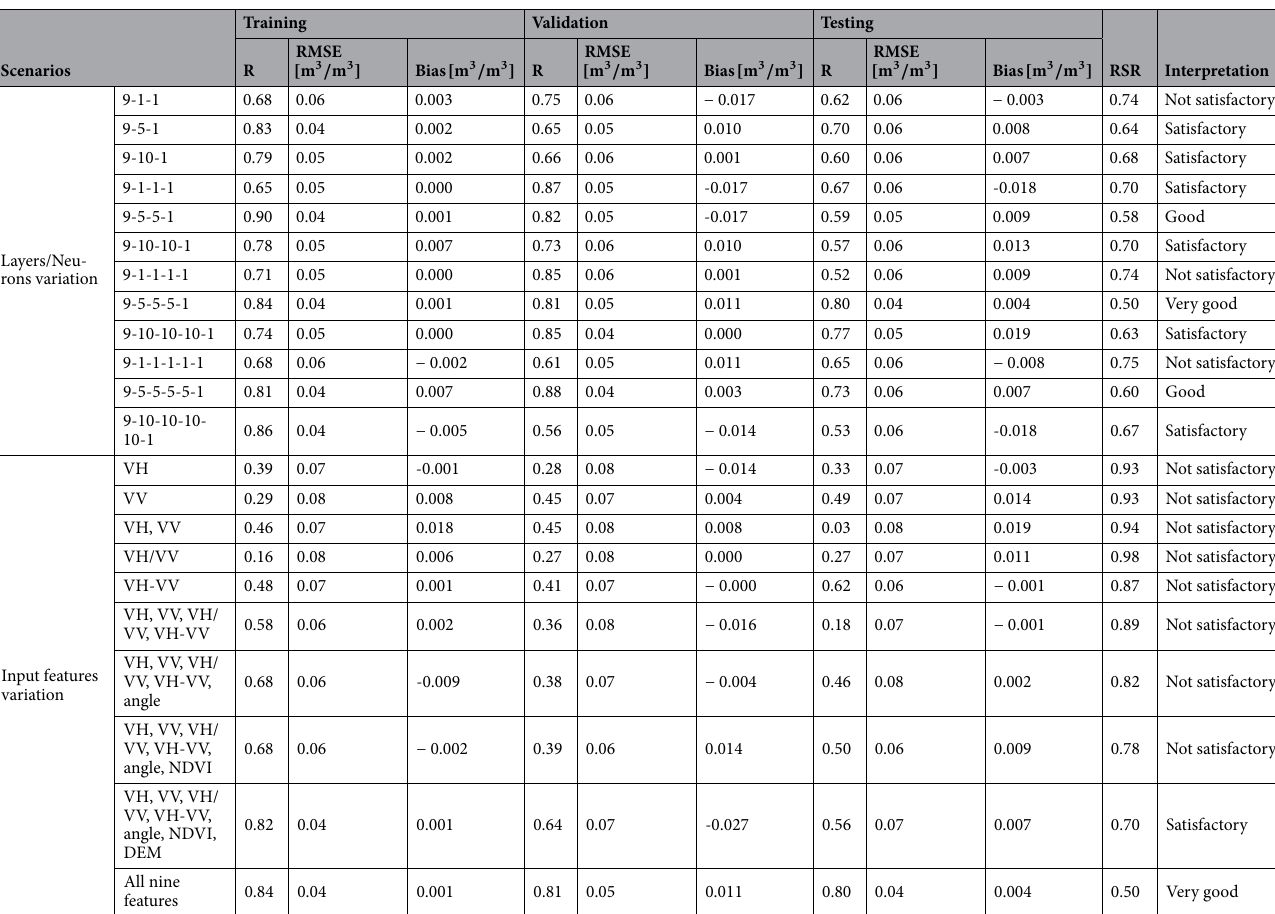
Table 2. Comparison of different scenarios by varying input feature combination and network architecture (hidden layers with